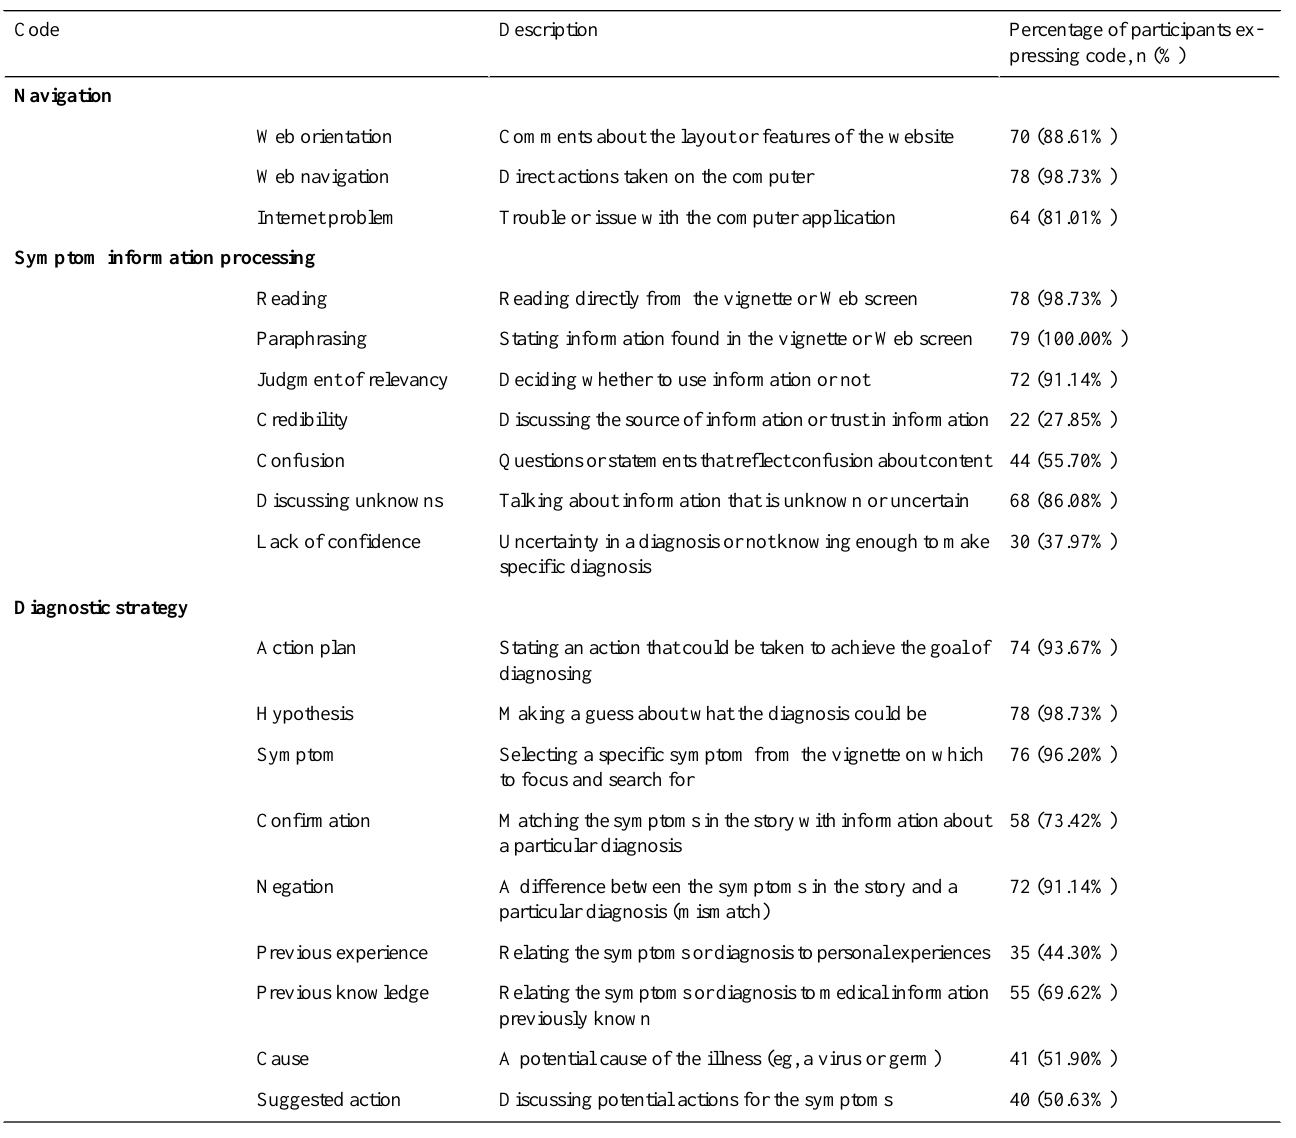
Table 3. Think-aloud content codes and participant endorsement